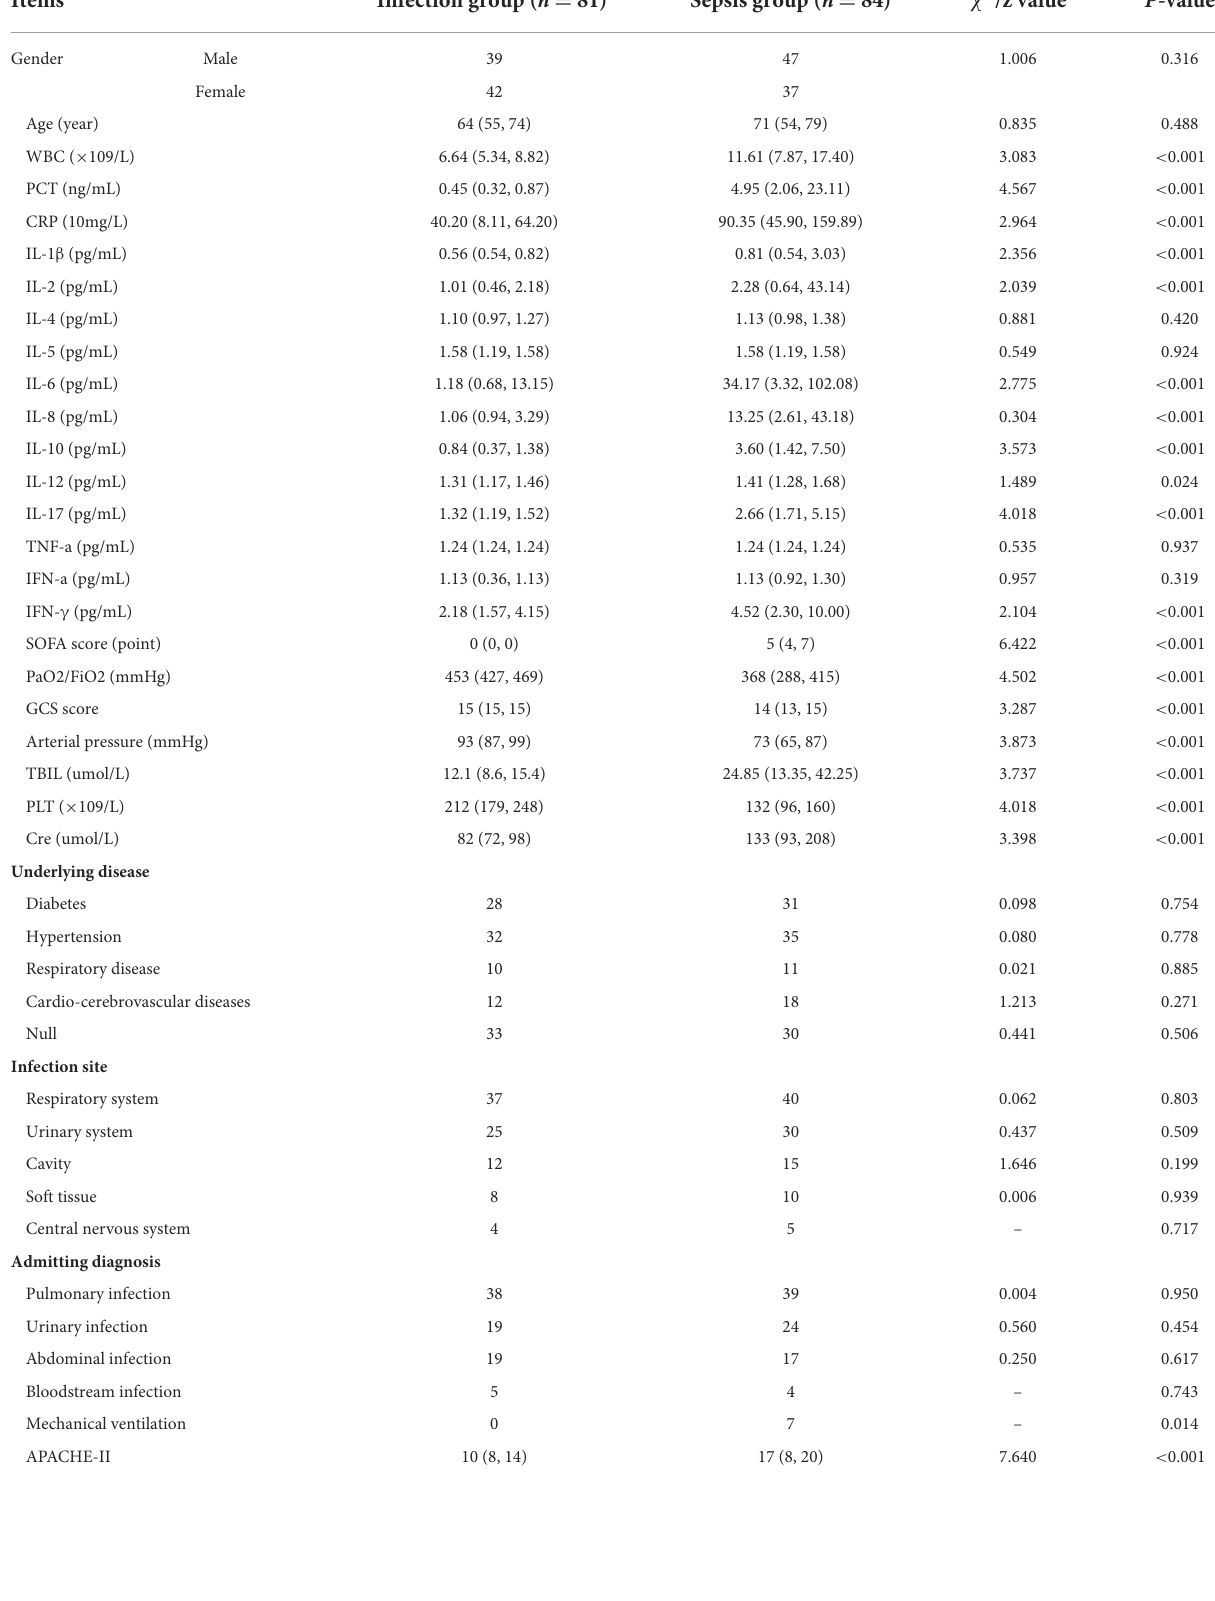
TABLE 1 Comparison of the distribution of clinical data between the infection group and the sepsis